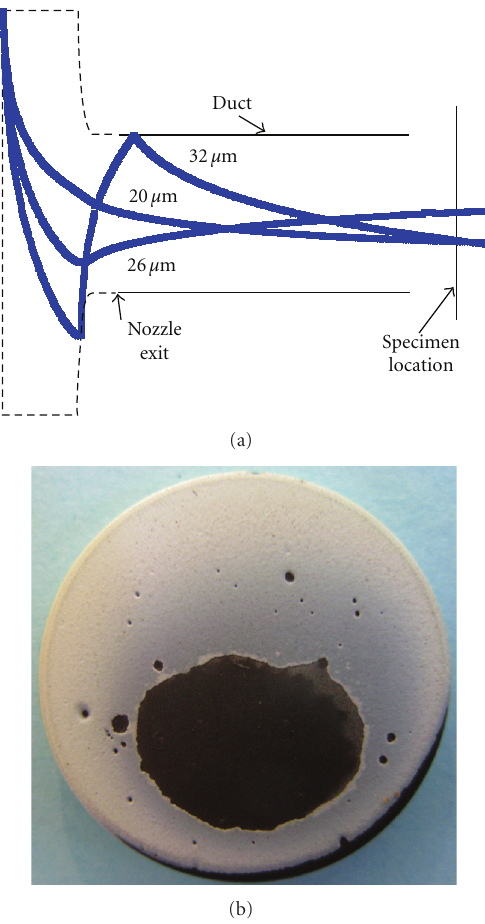
Figure 7: (a) Diagram of trajectories of three particles with di ff er- ent diameters in a Mach 0.5 ducted burner rig (0.305m long duct); (b) experimental observation of eroded pattern on test sample. Model predictions correspond to experimental observations that most particle strikes occur below the